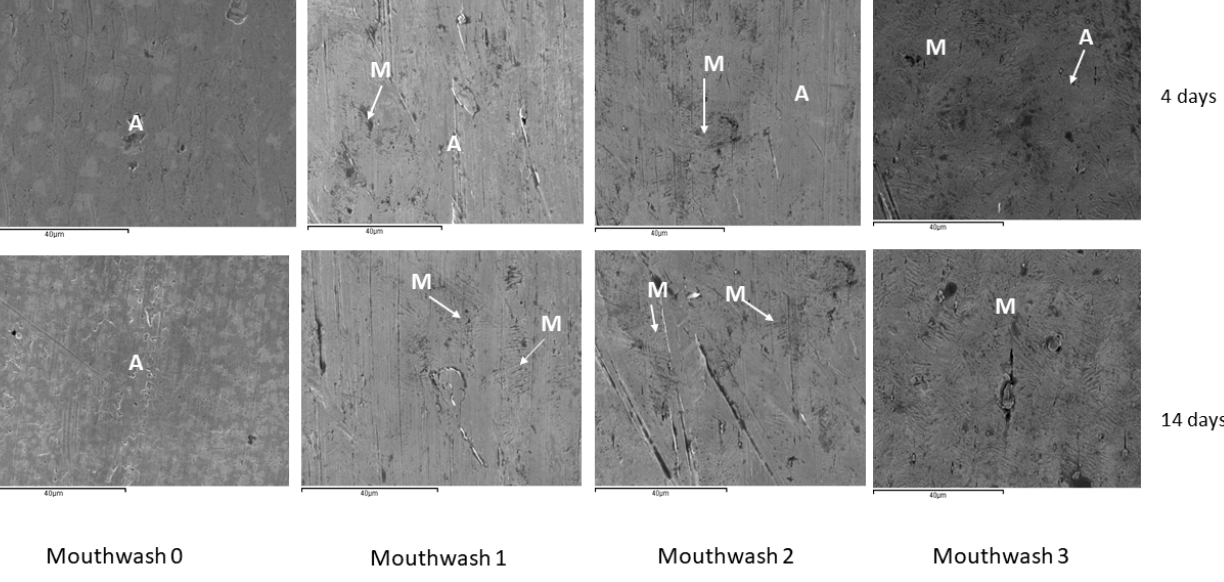
Figure 4. Microstructures of NiTi archwires after immersion for 4 and 14 days for the different mouthwashes. In the figures have been marked the phases martensitic (M) and austeinitic (A). The arrows indicate the phases.